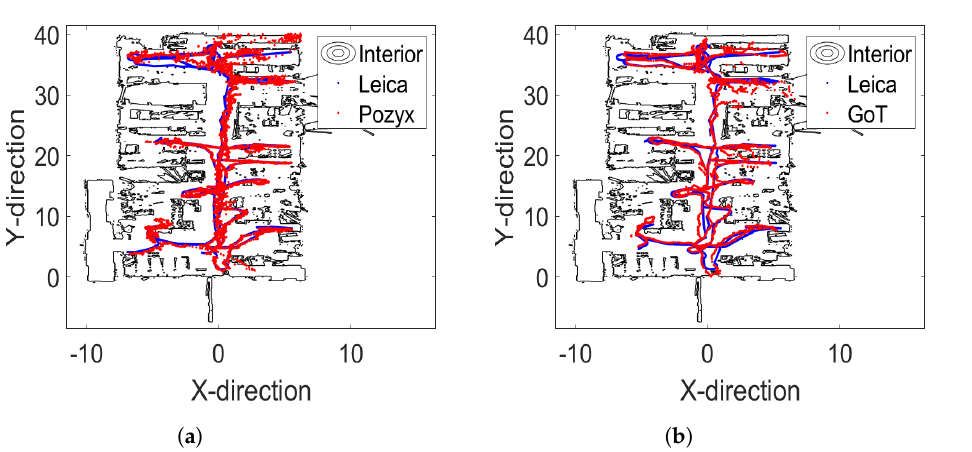
Figure 13. Two-dimensional traces for dynamic trajectory. ( a ) Laboratory outline (ROSmap) and Leica (blue)/Pozyx (red) traces. ( b ) Laboratory outline (ROSmap) and Leica (blue)/GoT (red)